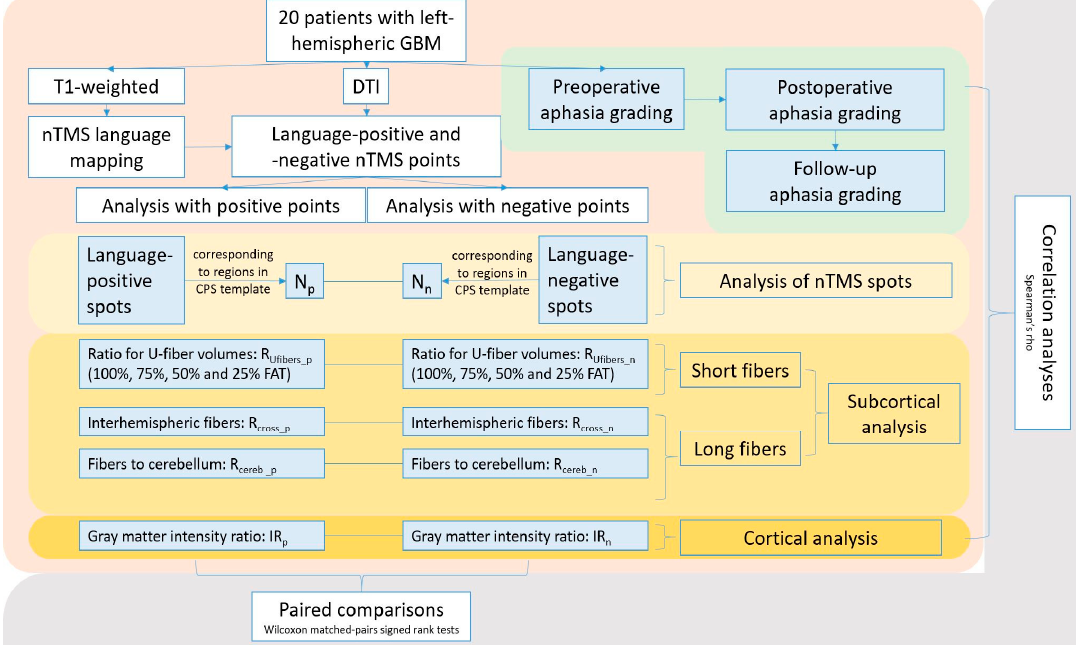
Figure 2. Overview of procedures and analyses. This scheme summarizes the study’s steps of analyses, which were performed based on data derived from language mapping by navigated transcranial magnetic stimulation (nTMS) and nTMS-based diffusion tensor imaging fiber tracking (DTI FT). Language-positive and language-negative nTMS points were used separately for the different analyses. The study cohort included 20 patients with left-hemispheric glioblastoma multiforme (GBM).